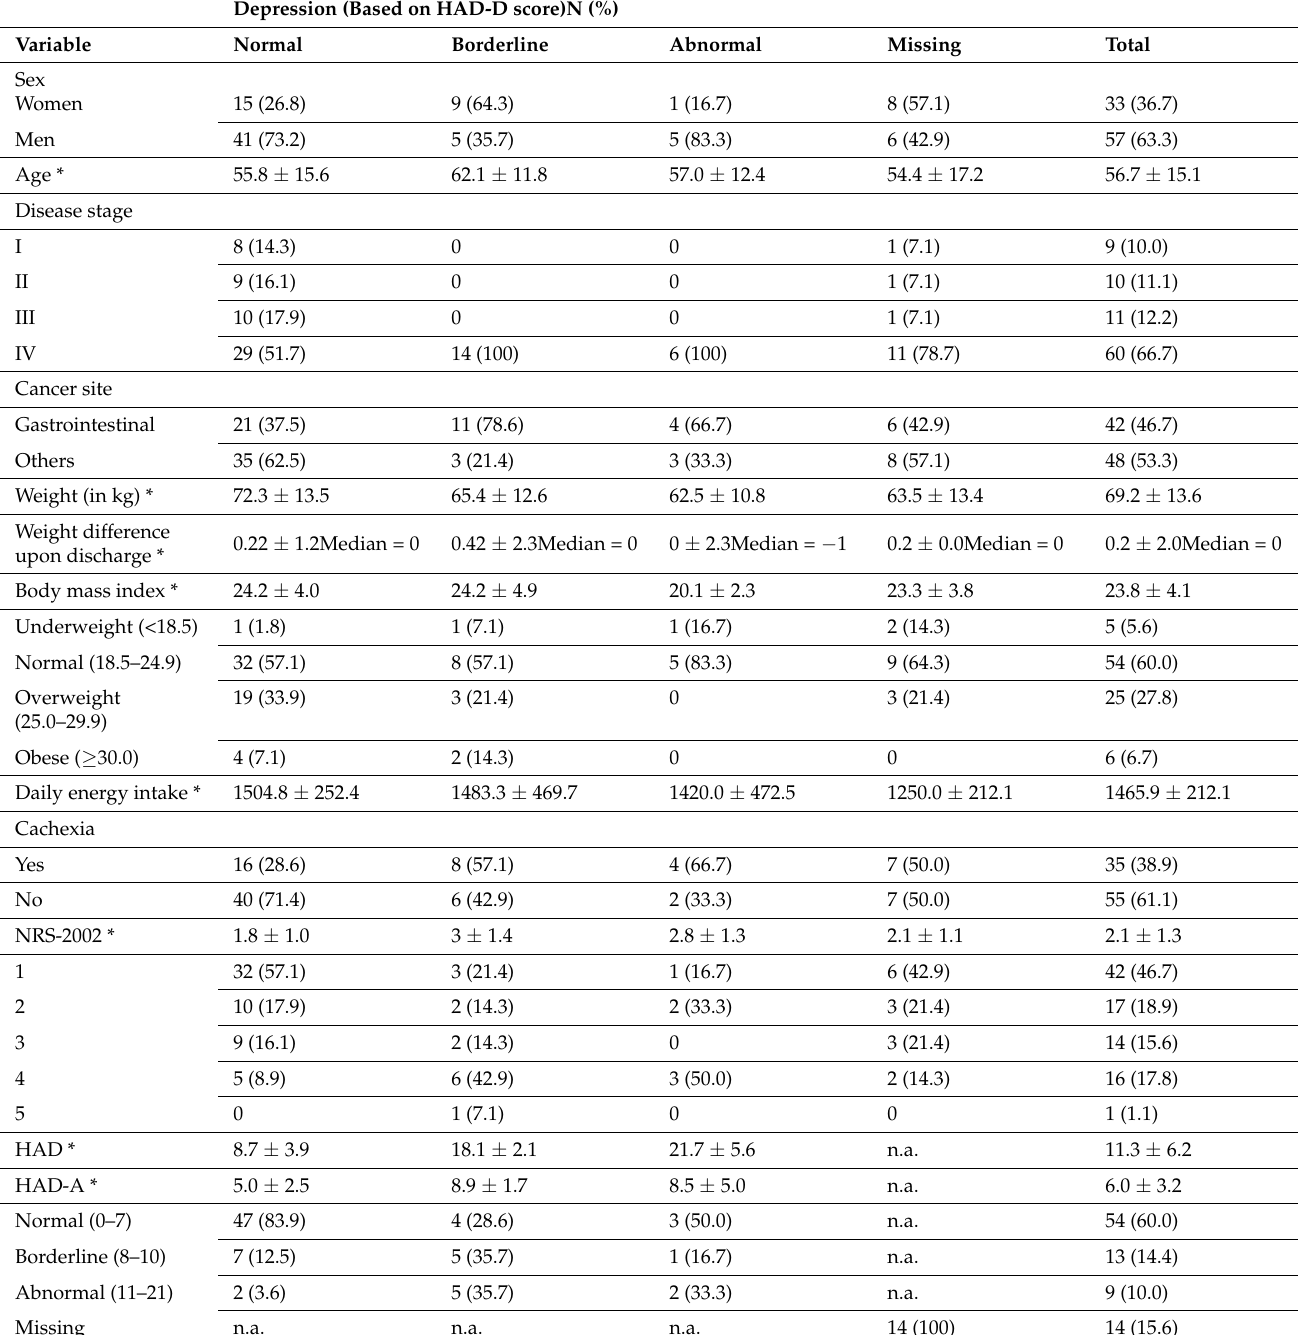
Table 1. Descriptive characteristics of the